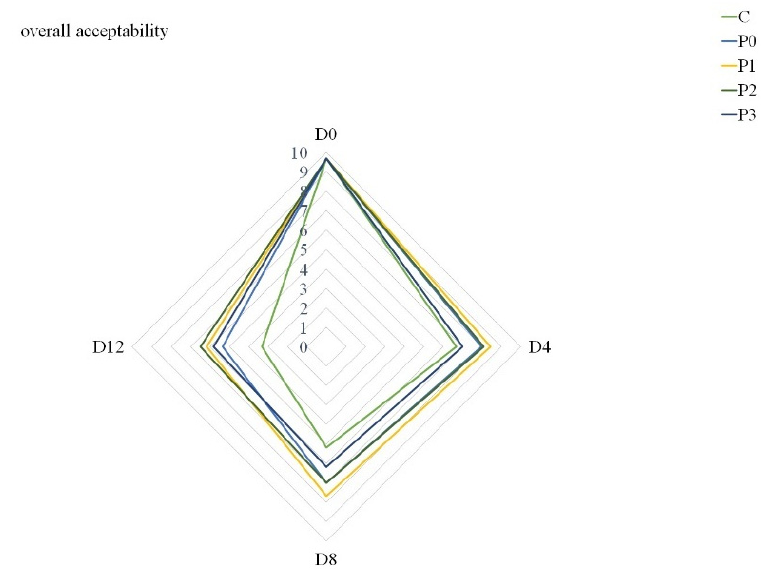
Figure 3. Overall acceptability of stored samples (C—uncoated pork loins; P 0 —gelatin-coated pork loins; P 1 —gelatin-coated pork loins with the addition of 1% propolis extract to gelatin coating; P 2 —gelatin-coated pork loins with the addition of 2% propolis extract to gelatin coating; P 3 —gelatin- coated pork loins with the addition of 3% propolis extract to gelatin coating; D0—Day 0; D4—Day 4; D8—Day 8; D12—Day 12).